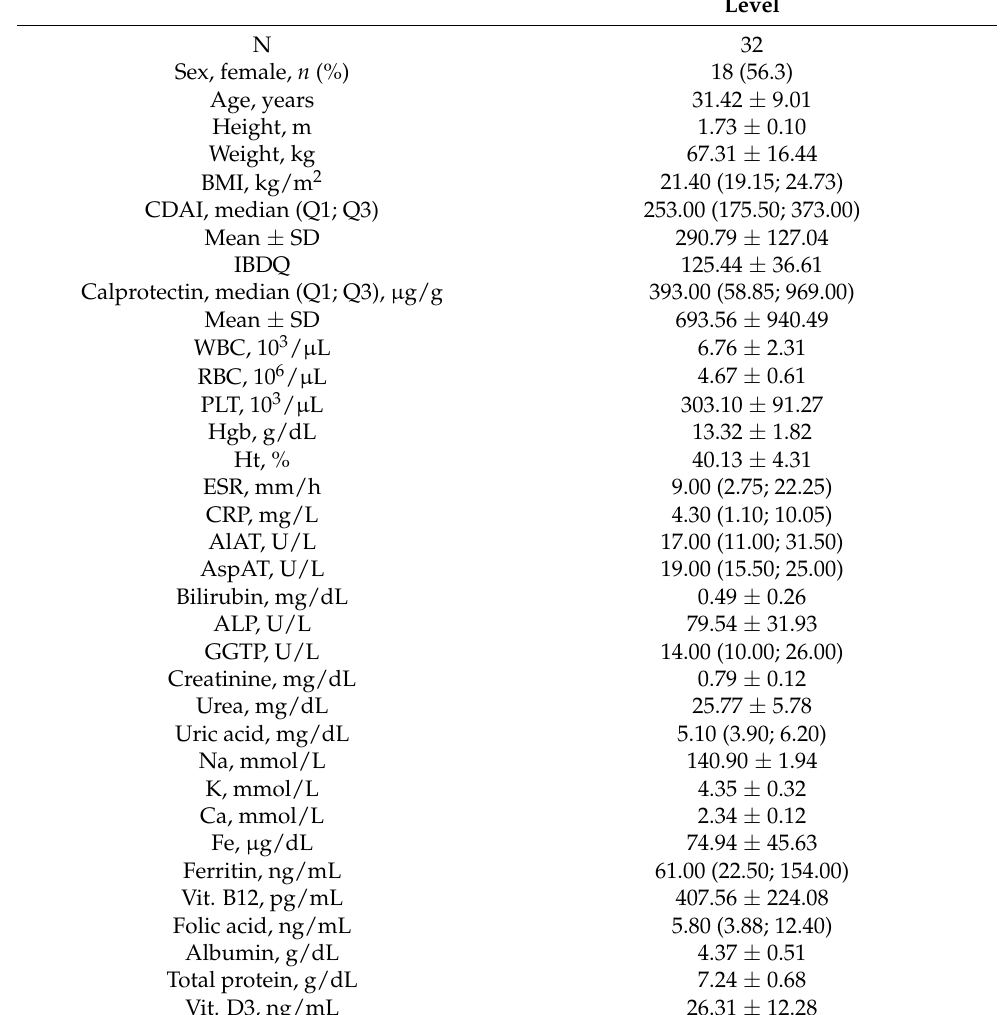
Table 1. Baseline characteristics.